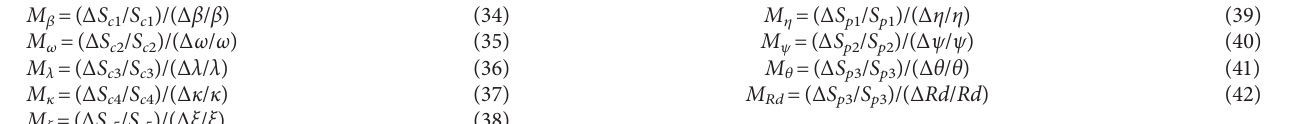
Table 3: Sensitivity indexes of different influencing factors of the MSS.